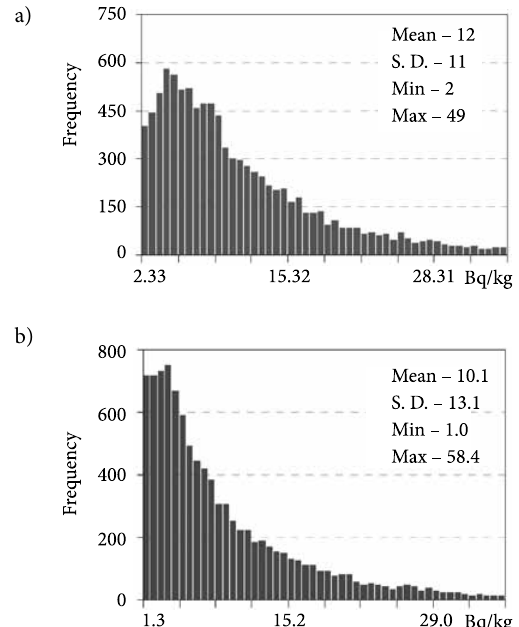
Fig. 2. Frequency histograms of 238 U (a) and 232 Th (b) activity concentration (d.w.) in Lithuanian